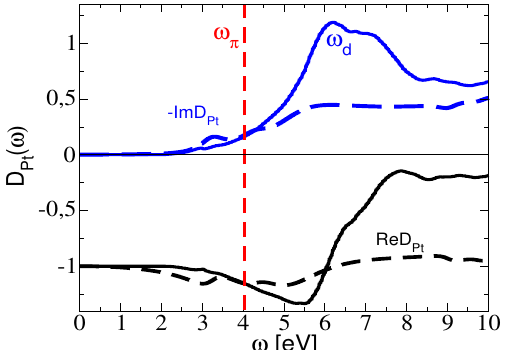
Figure 4. The ab initio (solid) and the empirical (dashed) Pt-skin surface response function, D Pt ( ω ) , for Q ≈ 0.The vertical dashed line shows the energy of the π plasmon in unsupported